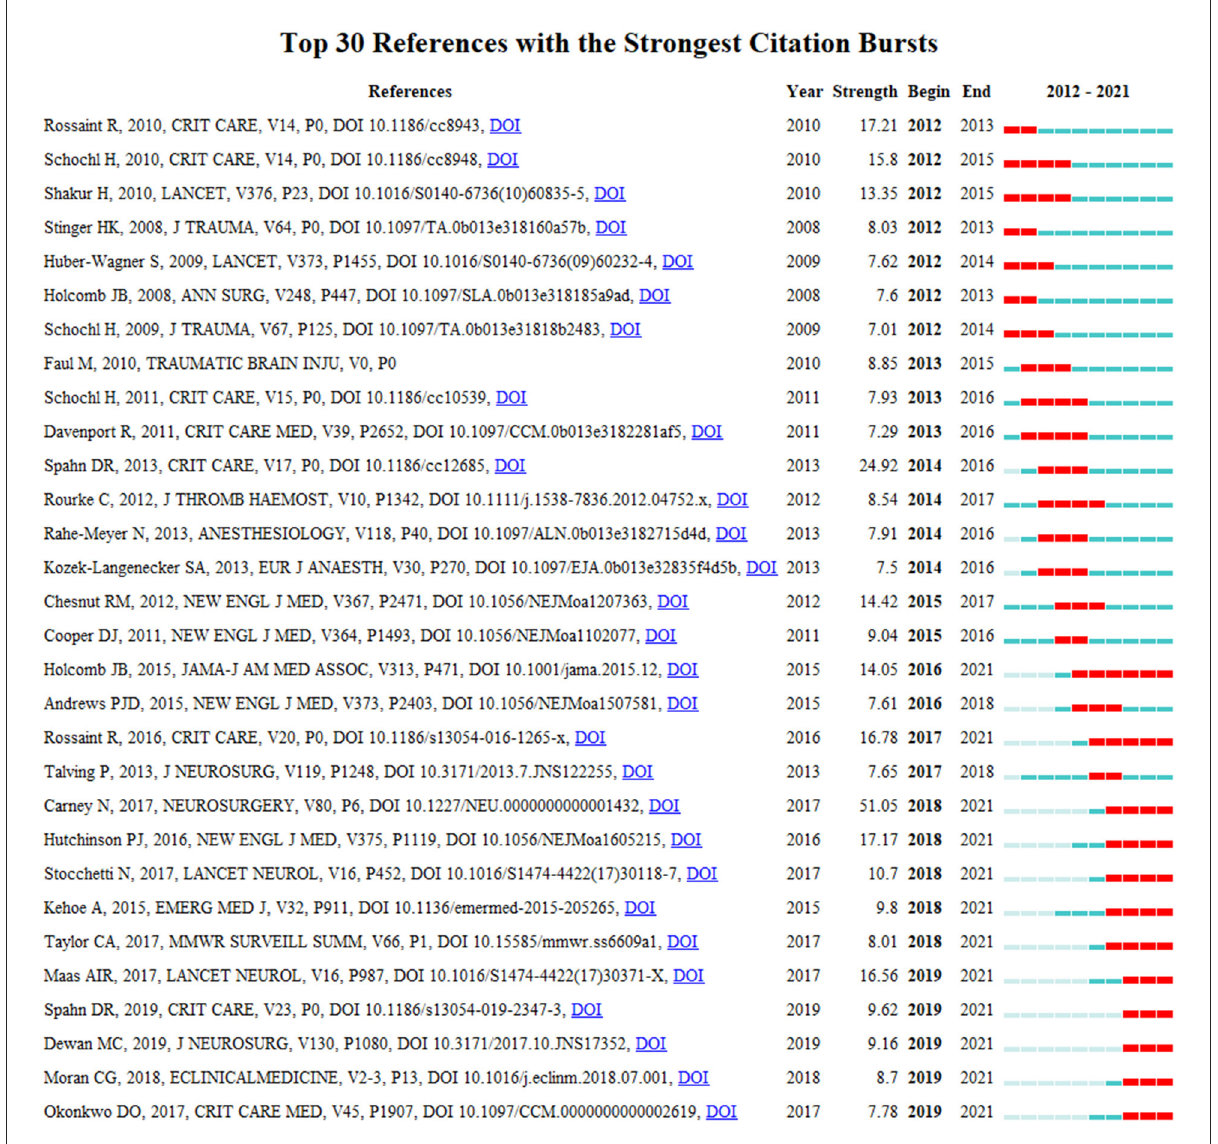
FIGURE7 Visual analysis of references bursts. The intensity value reflects the cited frequency. The red bar indicates citation frequency; green bars indicate fewer